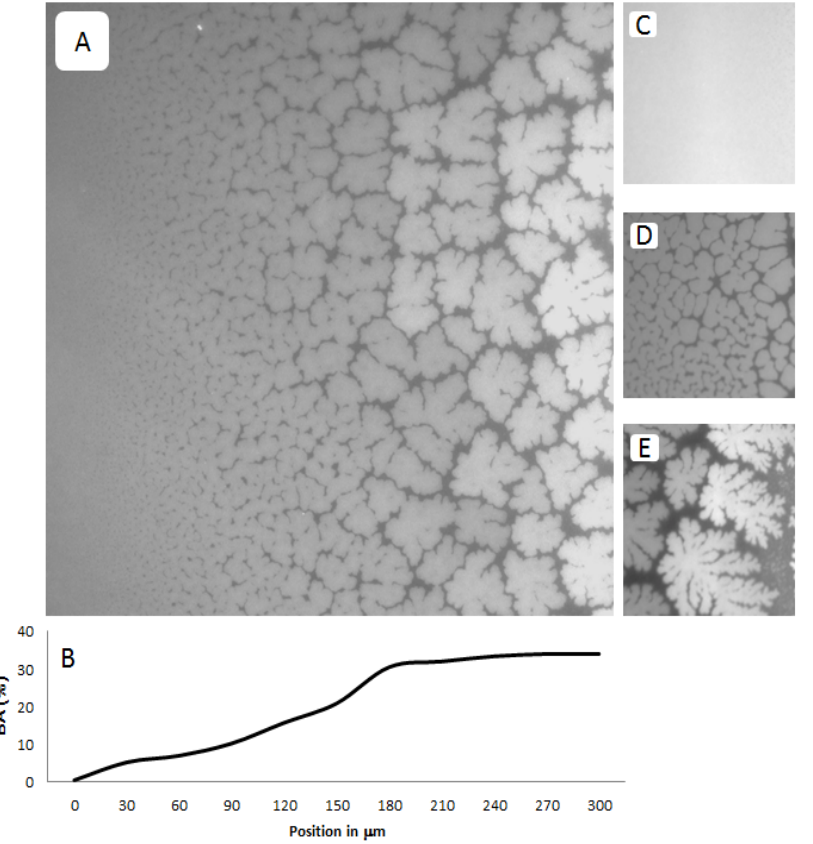
Figure 3. Representative EPI micrographs of a TYPE 1 physisorbed polymer-tethered